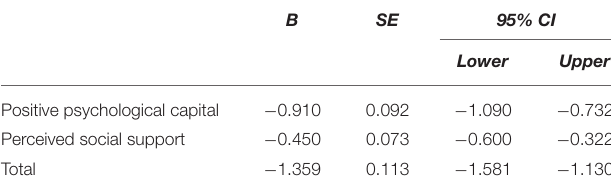
TABLE 2 | Test results of mediating effect